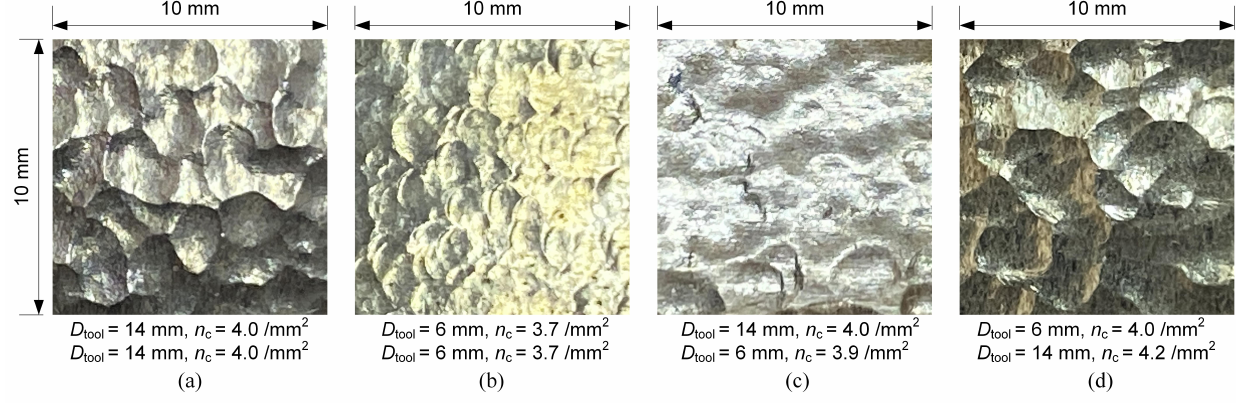
Figure 7. Surface morphology of hammering treated ( a ) sample 1, ( b ) sample 2, ( c ) sample 3 and ( d ) sample